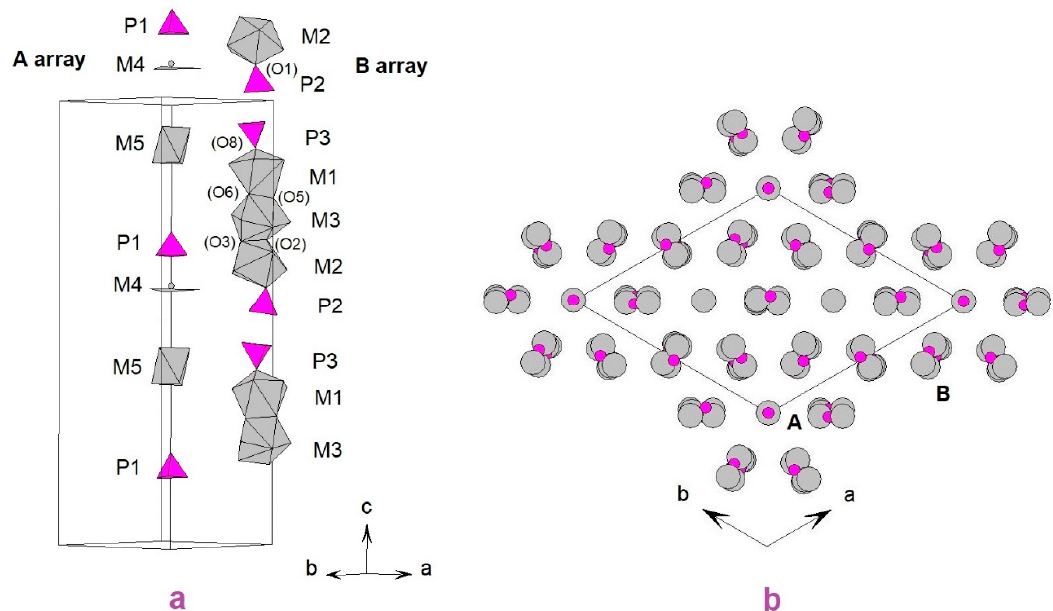
Figure 5. Framework of Me β -TCP structure: Detail of the ‘A’ and ‘B’ arrays ( a ) and view down c ( b ).